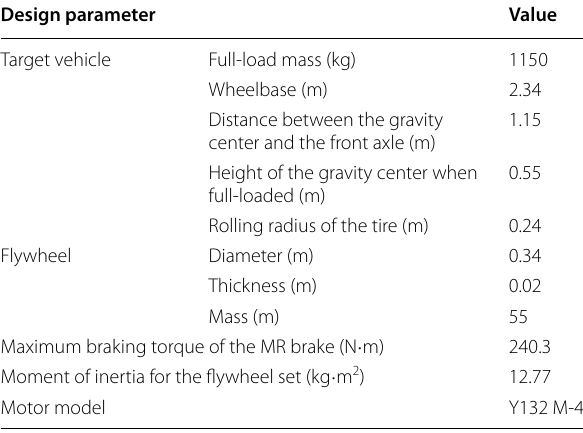
control algorithm. Figure 12 exhibits a comparison of the BPCC tracking effect without and with the pro- posed control algorithm. To comprehensively assess the control performance under various conditions, the experiments are carried out at three levels of pedal velocity: low, medium, and high. The results indicate that the actual pedal force is apparently lower than the ideal pedal force, primarily because of the response lag of the coil induction circuit without the proposed control algorithm. The mean absolute error is used to evaluate the force tracking effect. The mean absolute error of force tracking at low, medium and high pedal velocity is 17.19 N, 19.90 N, 30.49 N without con - trol algorithm respectively. As shown in Figure 12(b), with the help of the proposed control algorithm, the tracking effect turns much better, even at a high pedal velocity, and the mean absolute error of force tracking with control algorithm is 8.19 N, 8.90 N, 10.49 N. The